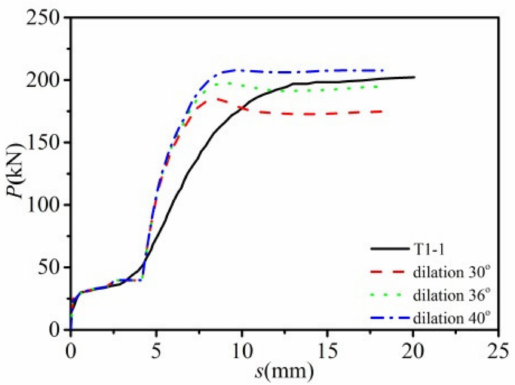
Figure 6. Effect of dilation on load-slip relationship of T1-1 specimens.